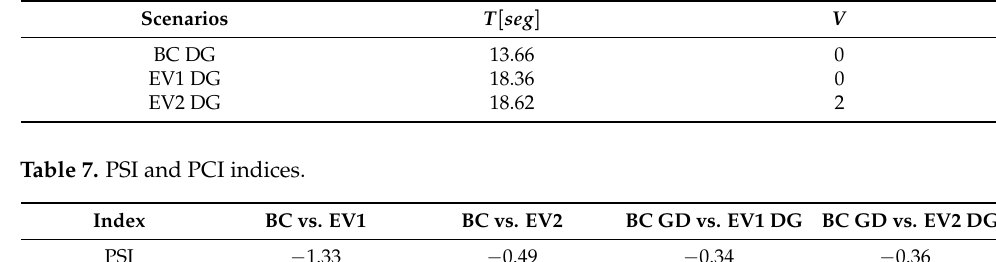
Table 6. Operating time and coordination violations in scenarios with DG.